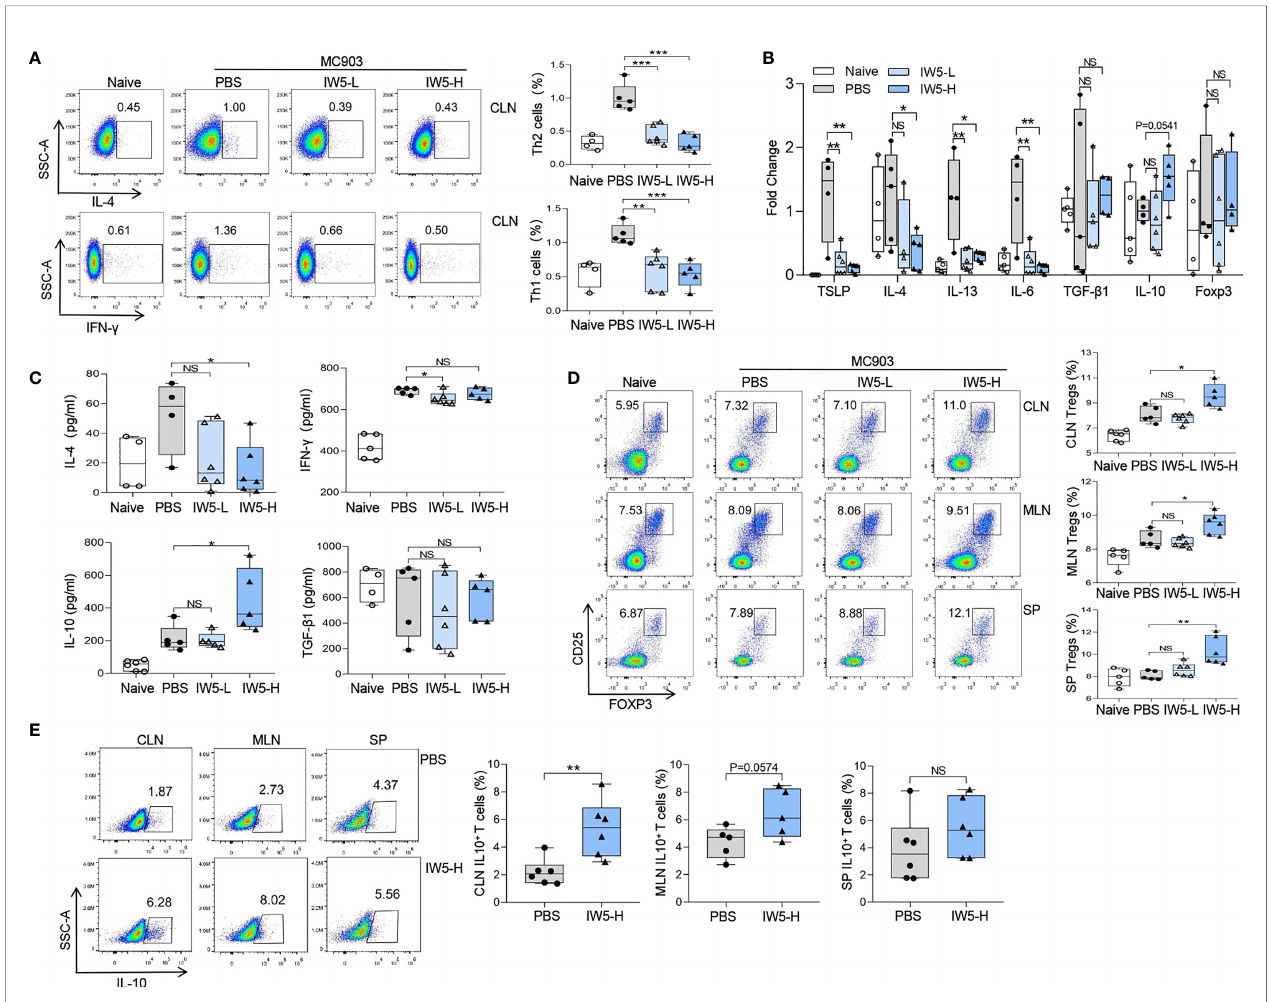
FIGURE 2 | IW5 inhibits Th1 and Th2 polarization and promotes Tregs differentiation. (A – D) AD mice were orally administrated with IW5-L or IW5-H for 27 days, and the cervical lymph nodes (CLNs), mesenteric lymph nodes (MLNs), and spleens were collected on day 40 for further analysis. Th1 (CD4 + IFN g + ) and Th2 (CD4 + IL-4 + ) cells from the CLNs (A) , and Tregs (CD4 + CD25 + Foxp3 + ) from the CLNs, MLNs, and spleens (D) were analyzed by fl ow cytometry. RT-qPCR shows mRNA expression of various cytokines from the ear lesional skin (B) , and ELISA shows concentrations of IL-4, IFN- g , IL-10, and TGF- b 1 in supernatants of cells from the CLNs (C) . (E) BALB/c mice were administrated with IW5-H (10 9 CFU IW5) or PBS daily for 20days. Percentages of CD4 + IL-10 + T cells from the CLNs, MLNs, and spleens were measured by fl ow cytometry. Data are shown as means ± SEMs, and representative of data from three independent experiments. Student ’ s t-test (unpaired; n = 4~6); *P < 0.05, **P < 0.01, ***P < 0.001 vs. PBS group. NS, not signi fi